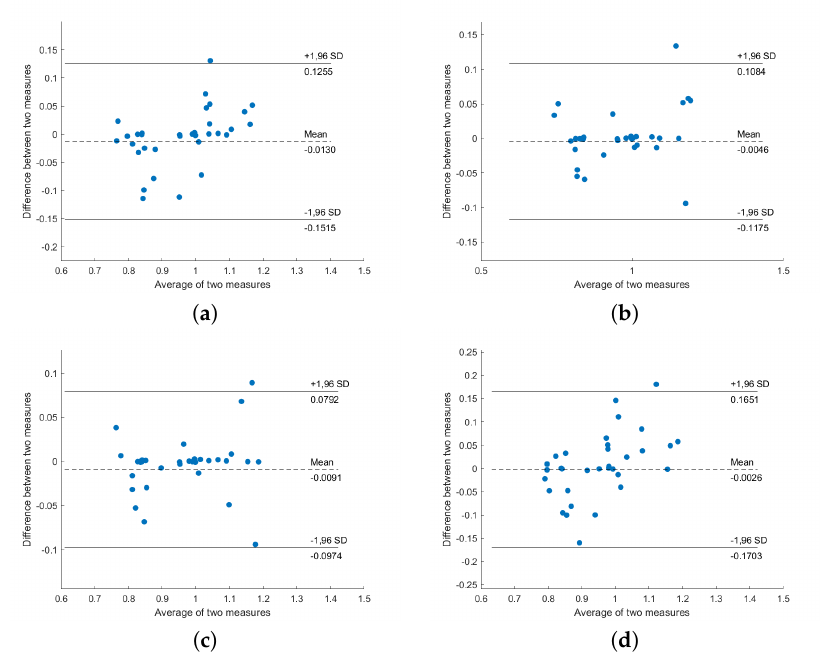
Figure A1. Bland–Altman plot of PPG-HRV and BCG-HRV, position “Back”: ( a ) S1; ( b ) S2; ( c ) S1 and S2; ( d ) all sensors.